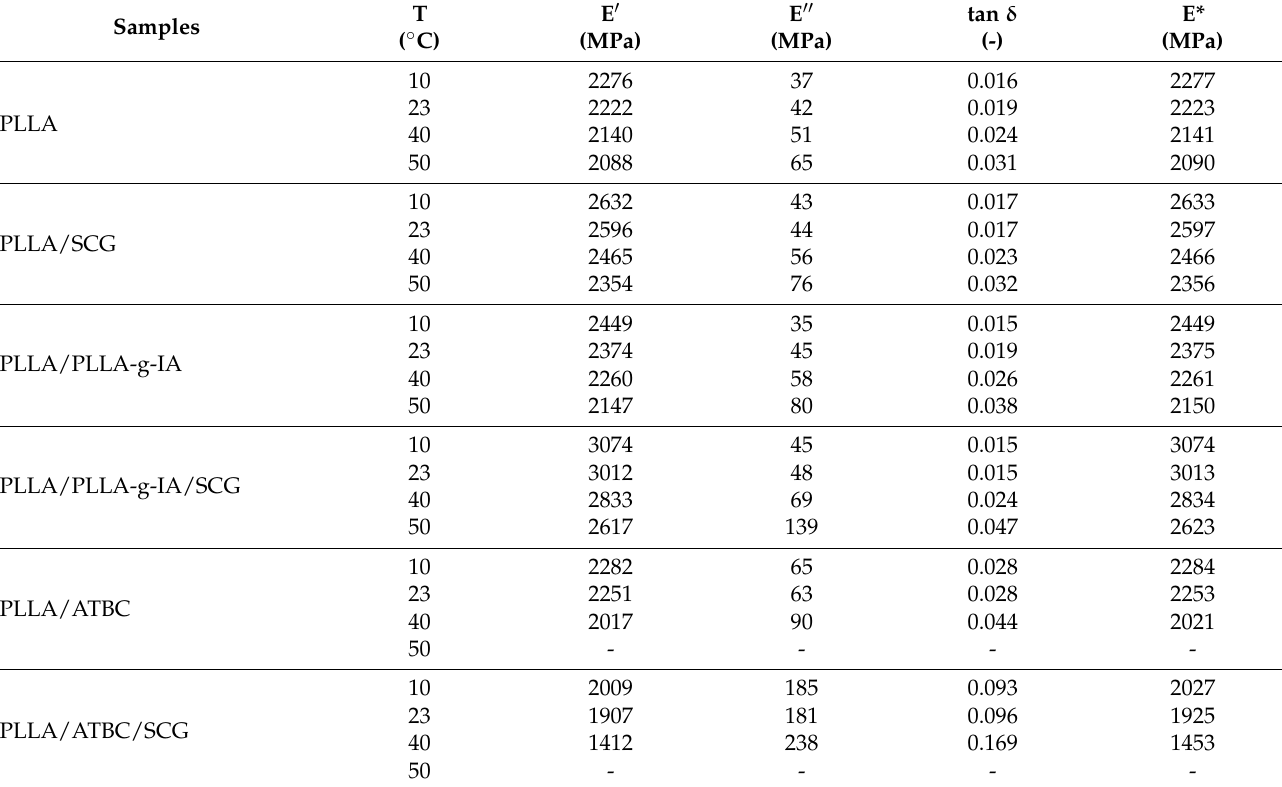
Table 8. Values of storage modulus, loss modulus, complex modulus, and loss